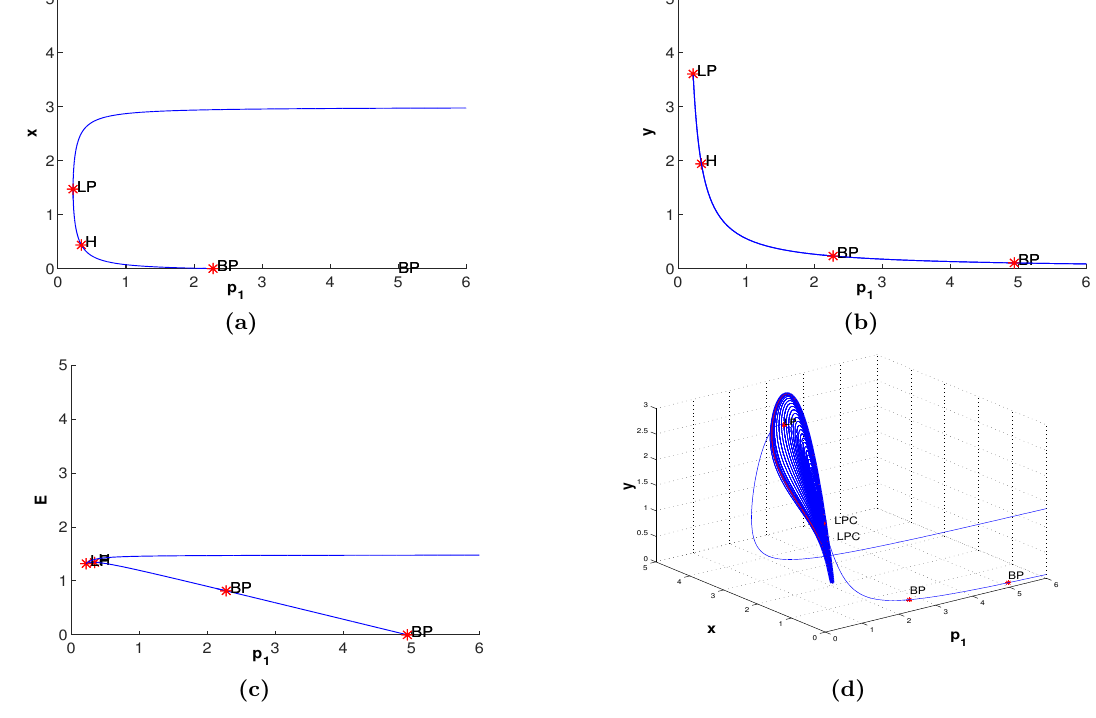
Figure 4. (a) Different steady state behavior of prey population for the effect of p 1 . (b) Different steady state behavior of predator population for the effect of p 1 . (c) Different steady state behavior of harvesting effort for the effect of p 1 . (d) The family of limit cycles bifurcating from the Hopf point H for p 1 .